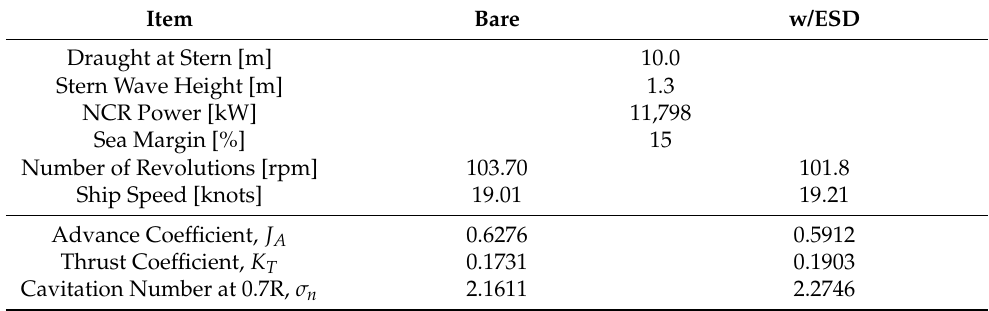
Table 10. Test conditions for the cavitation test.